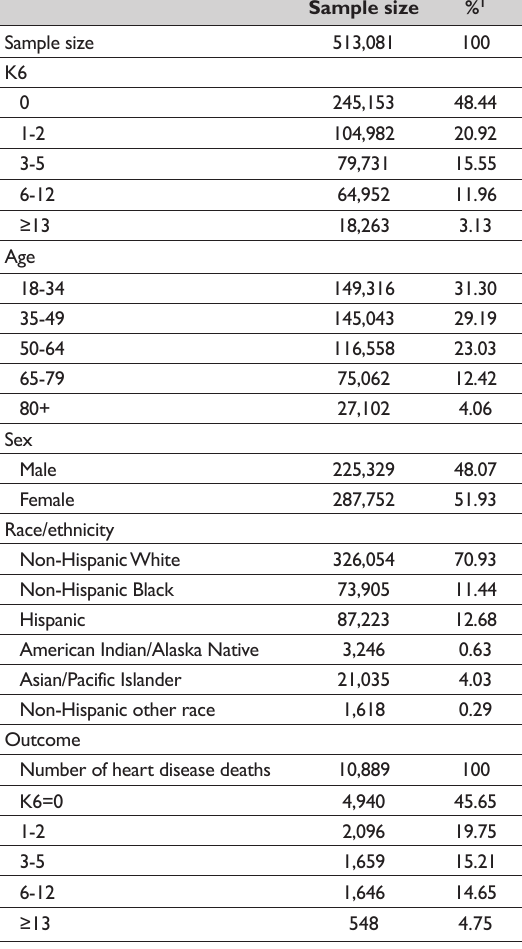
Table 1: Descriptive statistics for